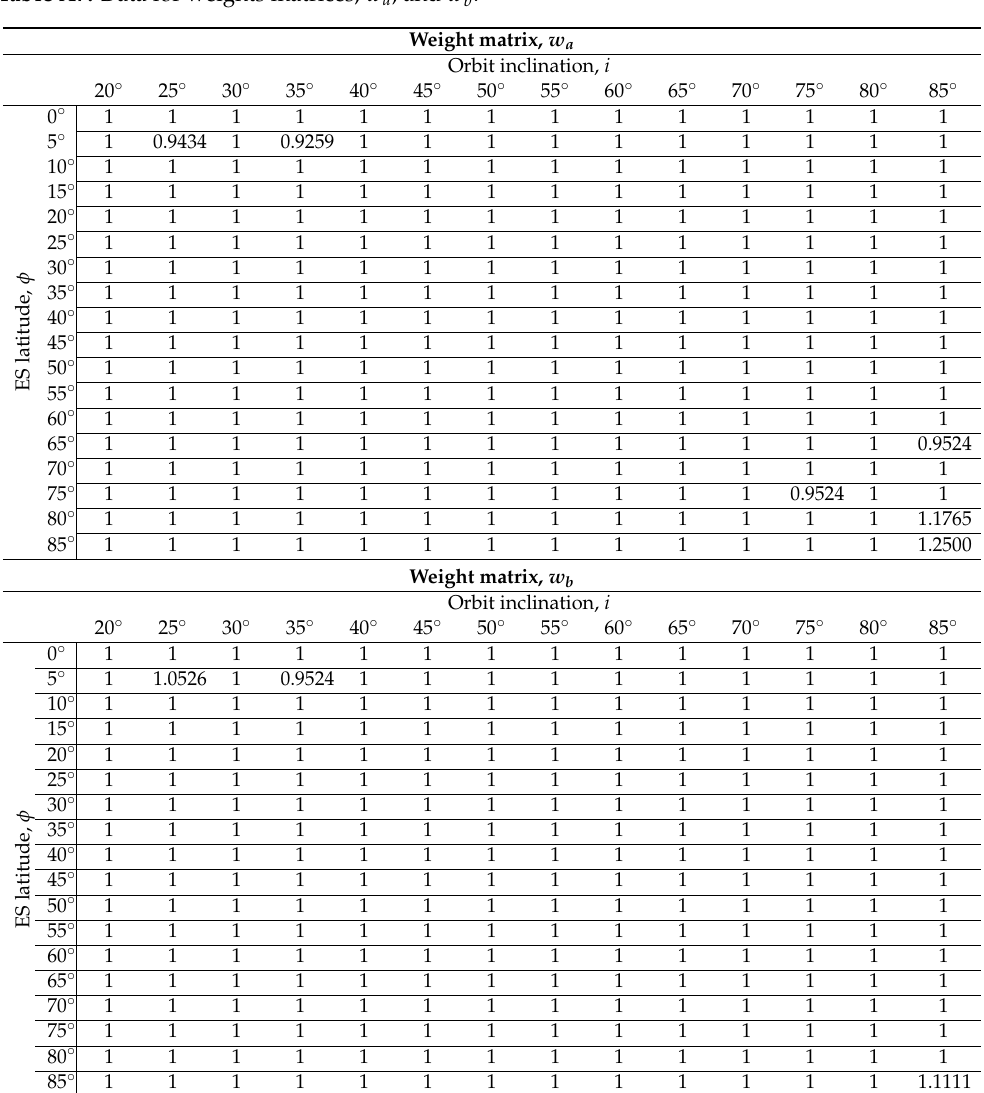
Table A7. Data for weights matrices, w a , and w b